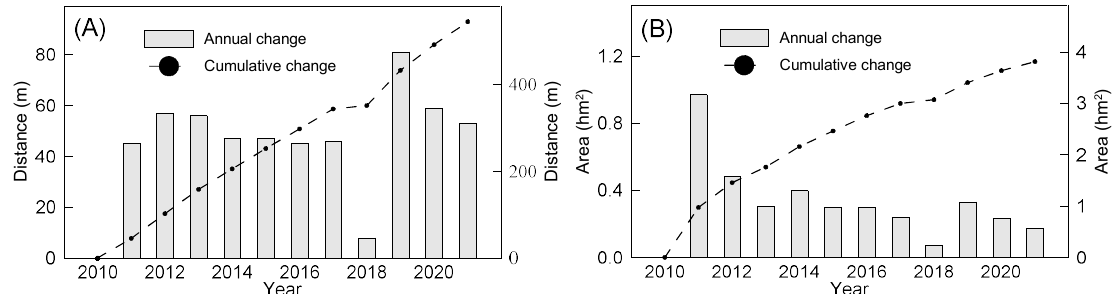
Figure 5. Annual and cumulative change of head position ( A ) and growth area ( B ) of the FESL taking 2010 as a refer-